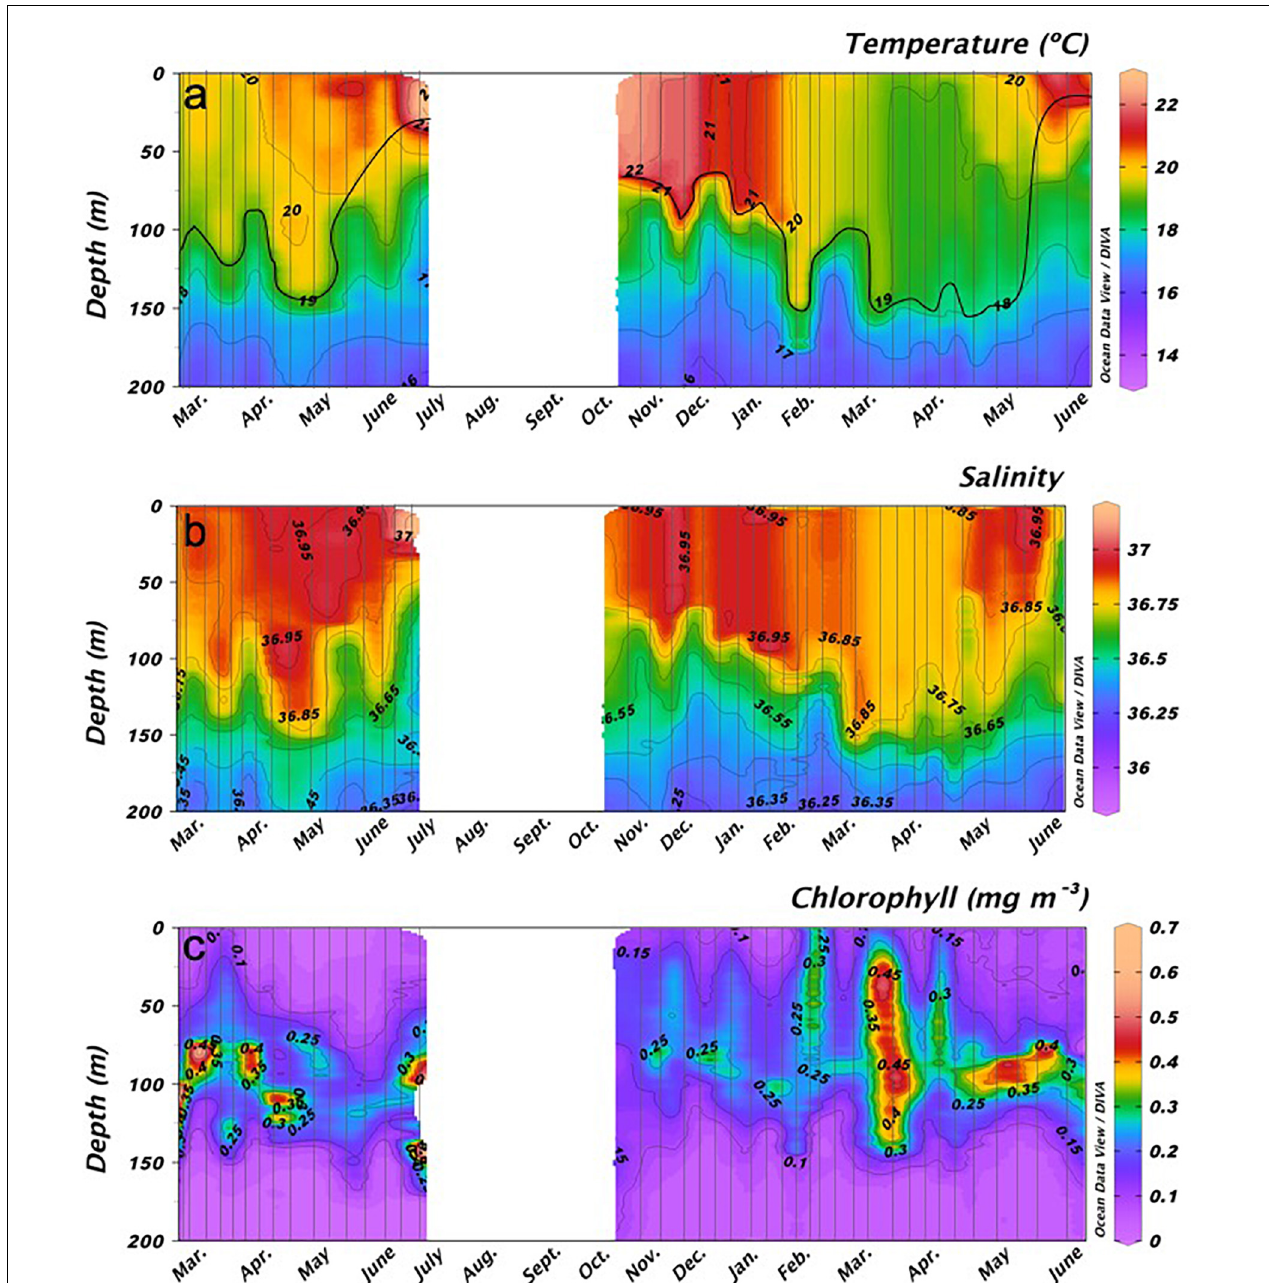
FIGURE 2 | Temporal variability of average (A) temperature ( ◦ C), (B) salinity, and (C) Chlorophyll a (mgChla m - 3 ) from surface to 200 m in stations 2, 3, and 4. White spaces indicate no data